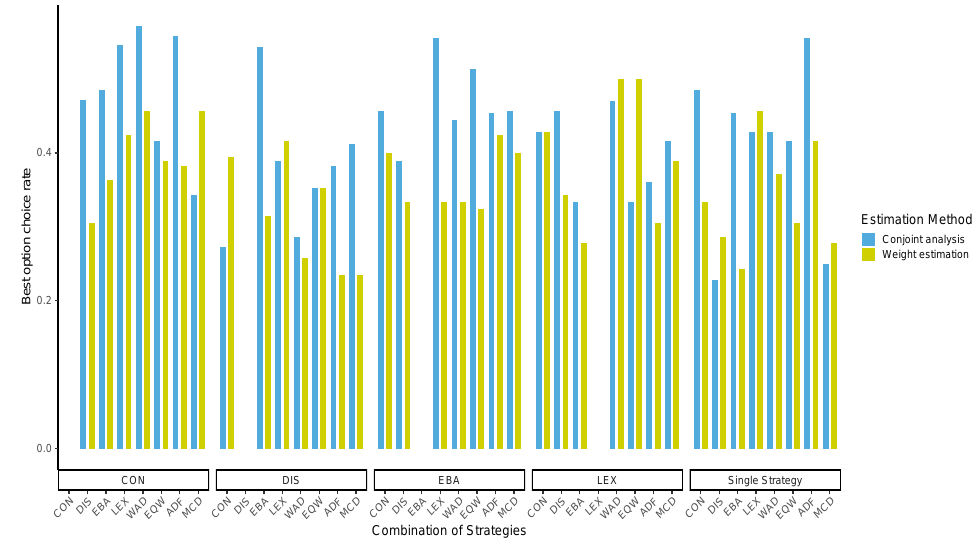
Figure A23. Best-choice rate of the conjoint analysis and the weight estimation task for single- and two-stage decision-making. Note: ADF: additive difference; CON: conjunctive; DIS: disjunctive; EBA: elimination by aspects; EQW: equal-weighted strategy; LEX: lexicographic; LEX-S: lexicographic semi-order; MCD: majority of confirming dimensions; STR: strategy; WAD: weighted